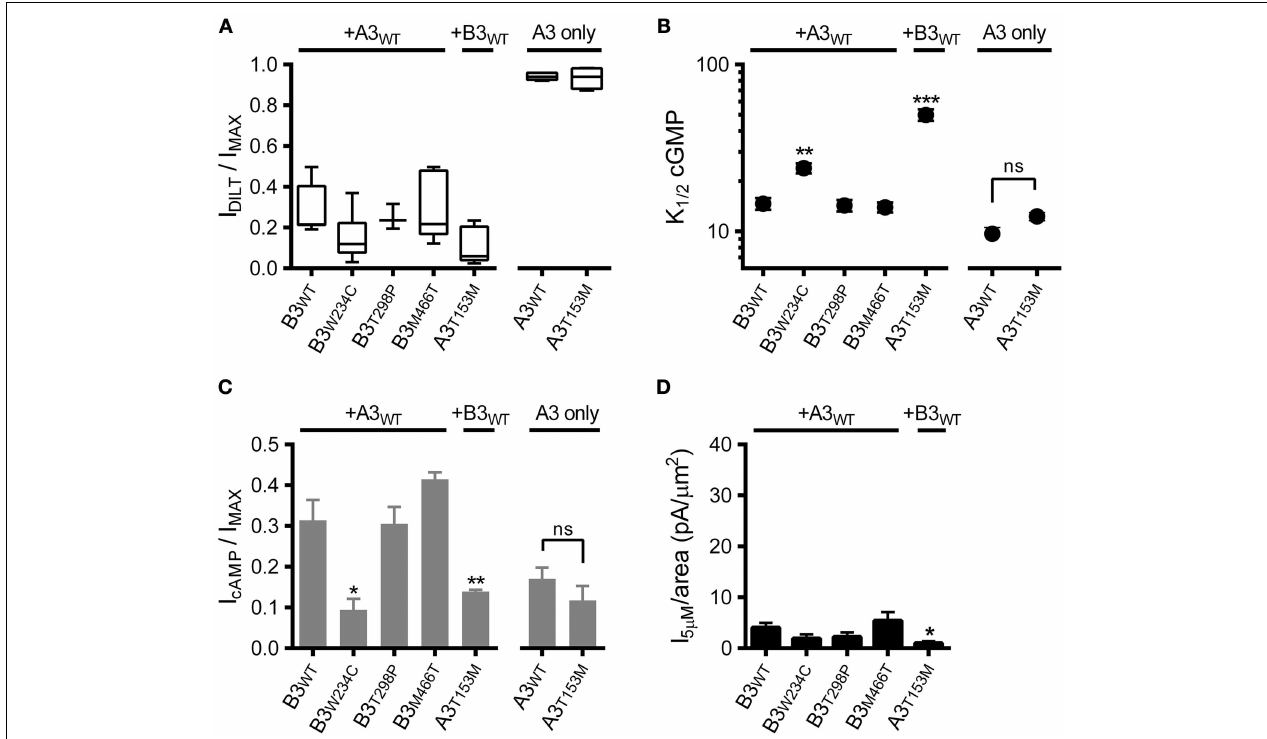
FIGURE 4 | Effects of single nucleotide polymorphisms on ligand sensitivity of heteromeric A3 + B3 channels. (A) CNGA3 and CNGB3 single nucleotide polymorphisms (SNPs) examined here form functional A3 + B3 heteromeric channels. Box plots summarizing the sensitivity to block by 25 µ M diltiazem in the presence of 1mM cGMP for SNP-containing channels compared to wild type A3 + B3 and A3-only channels. (B) Summary of K 1 / 2 cGMP for wild type and SNP-containing A3 or A3 + B3 channels. Data are based on best-fit Hill parameters